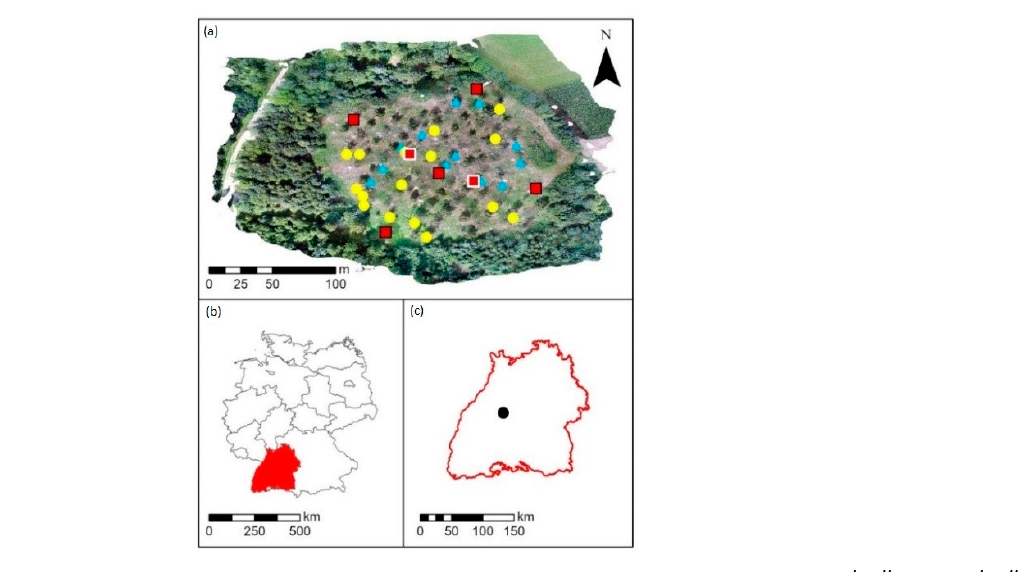
Figure 1. Study areas: ( a ) seed plantation near Wildberg (48°36 ′ 44 ″ N, 8°42 ′ 37 ″ E, 500 m a.s.l.) including measurement sites: blue triangles—topped sampled trees; yellow circles—non-topped sampled trees; red squares with black border—air temperature loggers; red squares with white border—passive samplers, ( b ) Baden-Württemberg in Germany (red fill) and ( c ) location in Baden-Württemberg (black circle). Table 1. Studied clones and their geographic